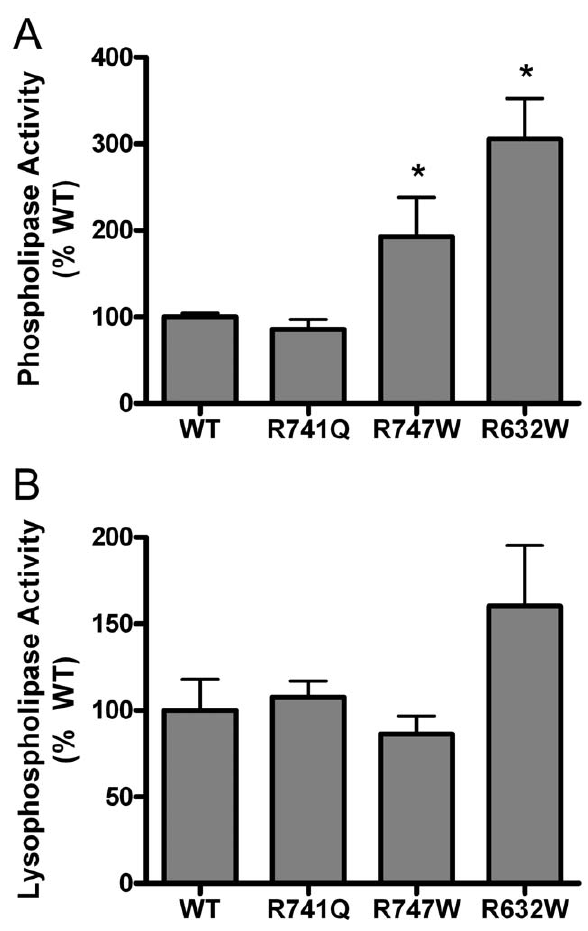
Figure 5. PLA2G6 mutations associated with dystonia-parkin- sonism do not impair phospholipase and lysophospholipase activity. Purified recombinant protein was produced for WT PLA2G6 protein and for PLA2G6 proteins containing missense mutations associated with dystonia-parkinsonism, Equal amounts of WT or mutant proteins were added to enzymatic assays utilizing (A) PC or (B) LPC as substrate. Relative rates of fatty acid release are shown for WT and each mutant protein (mean percent WT + standard deviation, n=3 independently prepared protein preparations for each of WT and 3 mutants). Asterisks indicate mean activities that were significantly different from WT (p , 0.05, unpaired t-test). Although an initial experiment with n=1 recombinant protein preparations indicated decreased activity of all three mutant proteins relative to WT, results similar to those shown in panels A and B were observed in all subsequent experiments, which included at least 3 additional independent protein